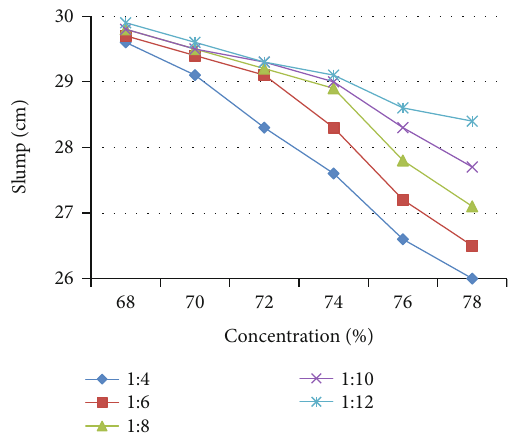
Figure 3: Relationship curve between slump and concentration of total tailings mixed slurry.